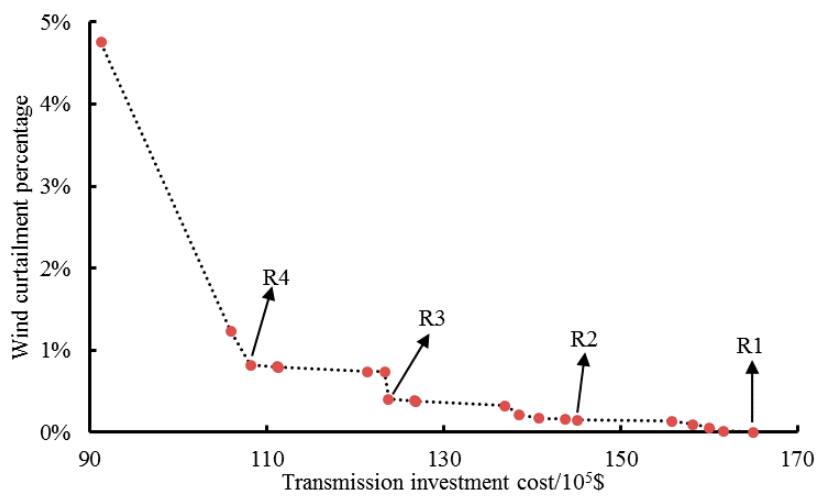
Figure 7. Feasible planning results for IEEE RTS-24 system.